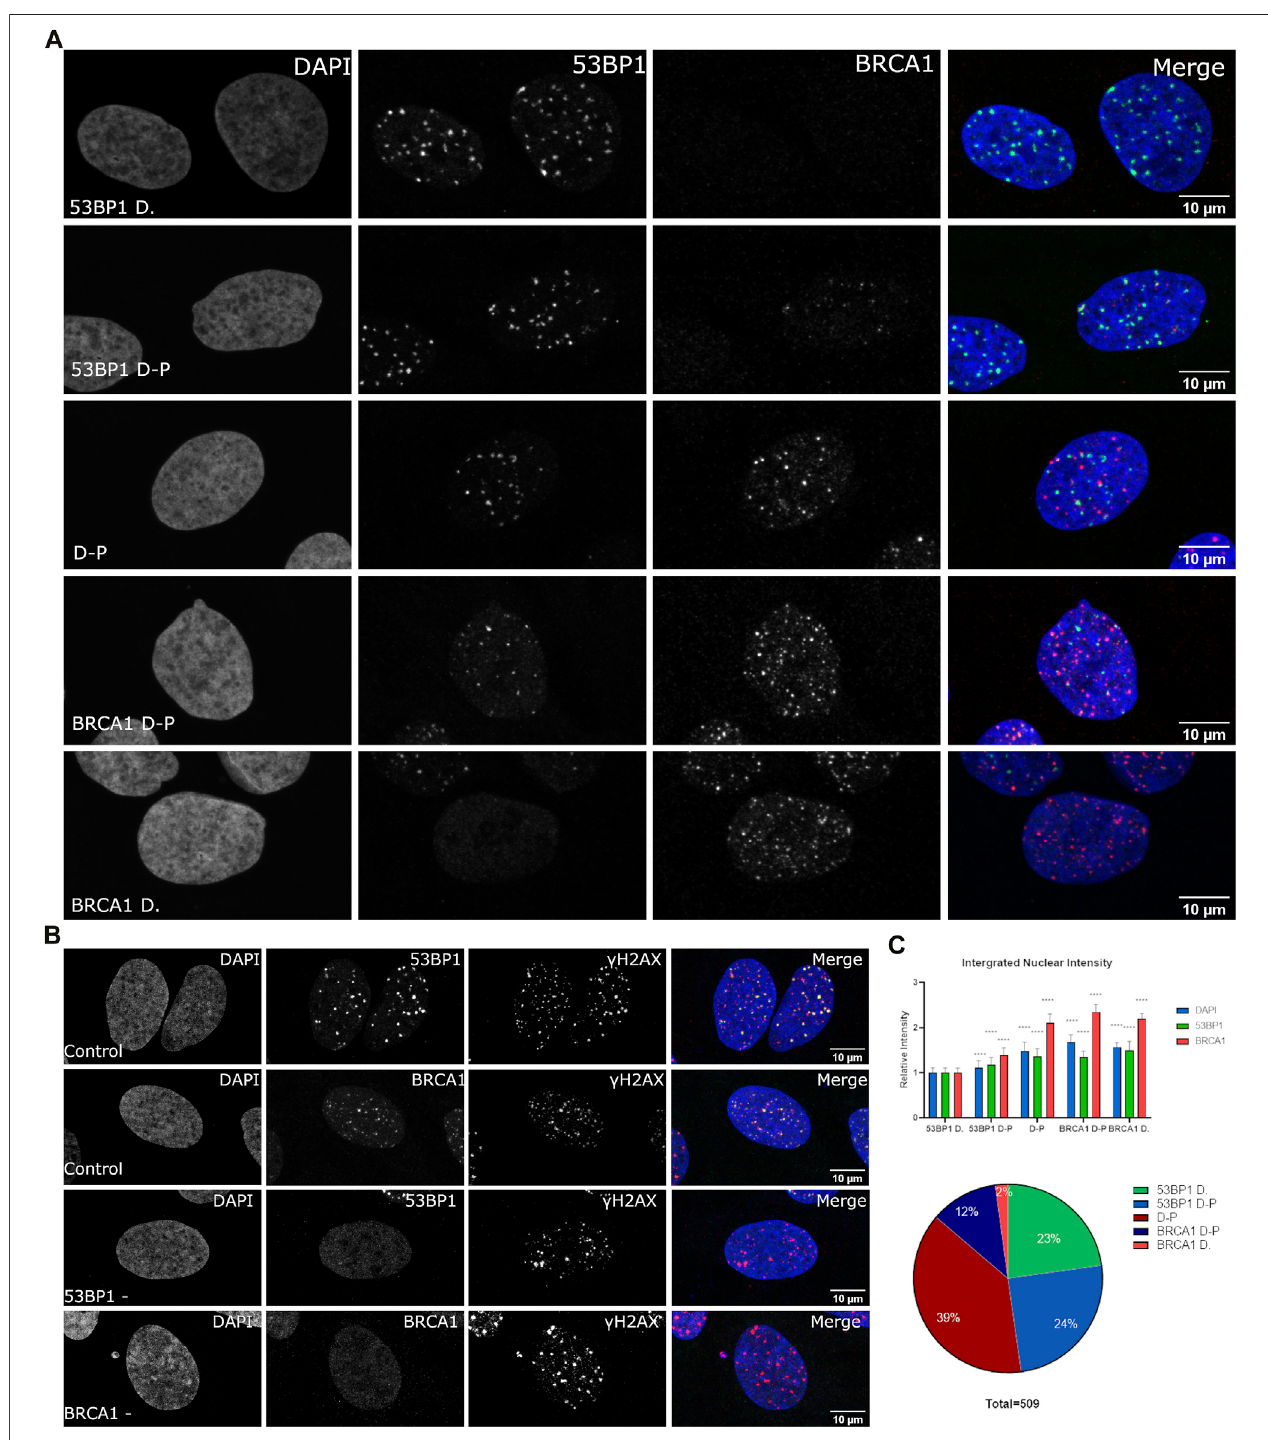
FIGURE 1 | Variation in BRCA1 and 53BP1 recruitment in asynchronous cell populations. WT U2OS cells were fi xed 1 h post 2 Gy irradiation and immunostained with antibodies for 53BP1, BRCA1, and γ H2AX showing heterogeneity in recruitment to DSB. (A) Cells were classi fi ed subjectively into fi ve categories based on their relative abundance of BRCA1 and 53BP1 in foci: 53BP1-dominant cell (53BP1 D), 53BP1-dominant double-positive cell (53BP1 D – P), 53BP1 – BRCA1 – positive cell (D – P), BRCA1 dominant double-positive cell (BRCA1 D – P), and BRCA1-dominant cell (BRCA1 D). Cells were normalized using the intensity values of the 53BP1- dominantcategory,wherecellspredominatelyareinG1withlowDAPIintensity. (B) DNAdouble-strandbreakswerecon fi rmedincellsthatwerenegativefor53BP1foci and cells that were negative for BRCA1 foci using γ H2AX as a marker for DSB foci. (C) The DNA, BRCA1, and 53BP1 were measured for 509 cells obtained from four